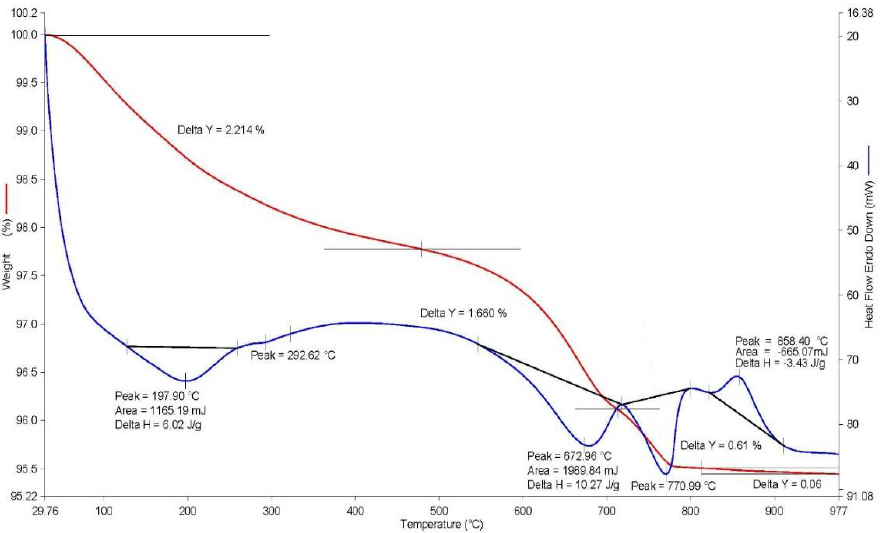
Figure 3. The OS